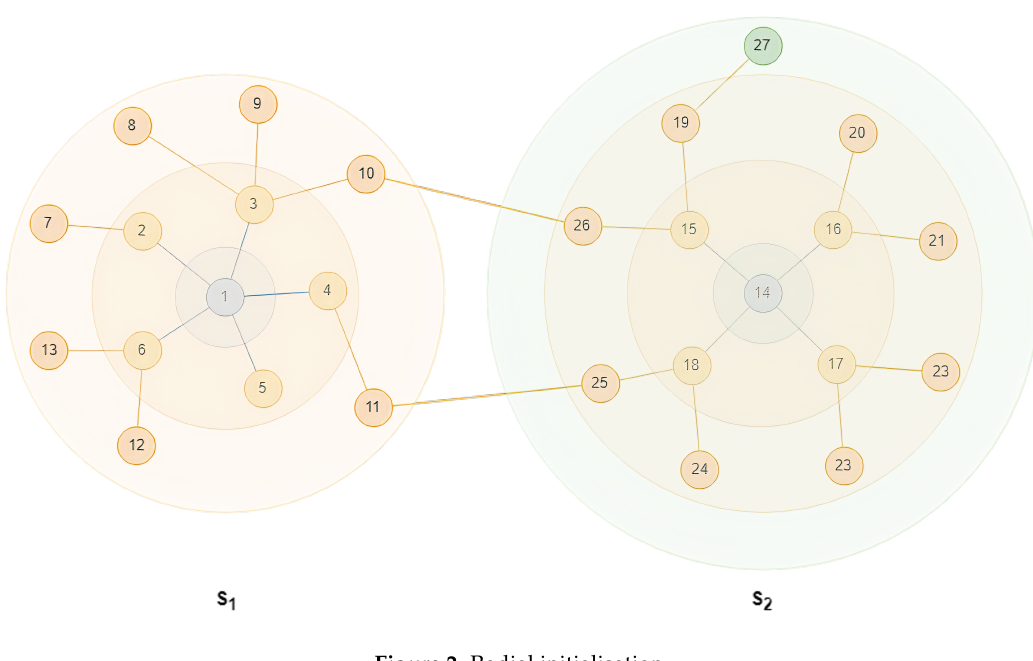
Figure 2. Radial